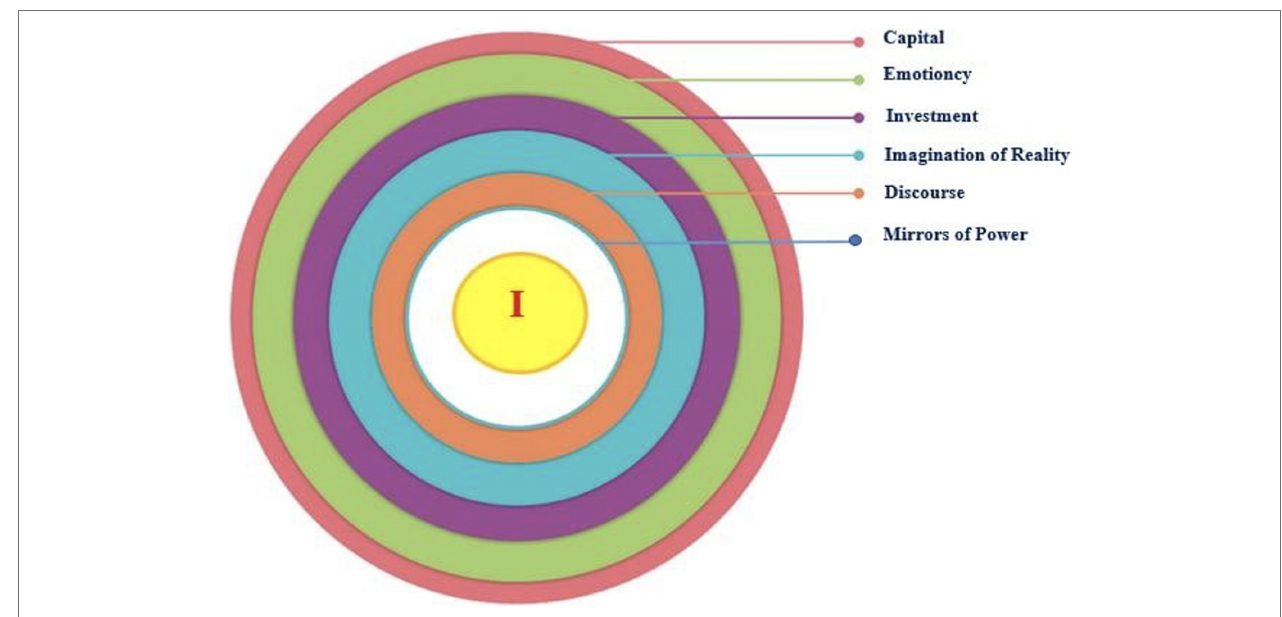
FIGURE 1 | A new conceptual framework for teacher identity.